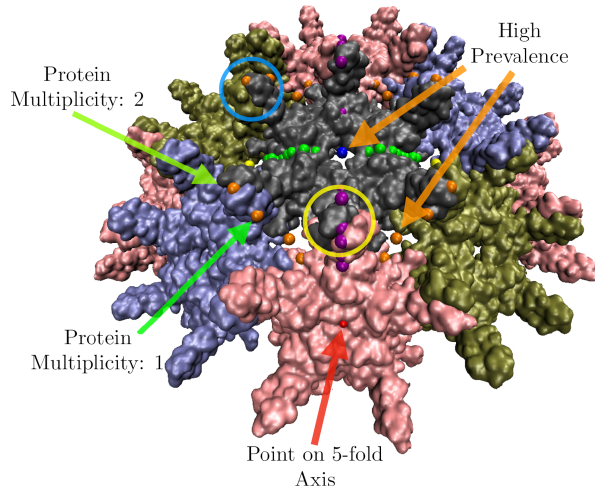
Figure 10. Features of the point array fitting algorithm. Here we have docked the gauge points on HBV, a T = 4 virus with dimeric protrusions. We only consider the point arrays with gauge points nearest the most radially distal protruding features, e.g., the nearest gauge points to the protruding dimers are GP: 17, 18 and 19 (yellow circles) and 4 and 5 (blue circles), see Table 2. In this example, there are 3 gauge points that would have fallen through the capsid surface when docked, which were instead stopped at their minimum distance to the surface. We see that most points sit on the surface of the proteins, and some on the symmetry axes in between proteins. Points which are near more than one protein are weighted more in the RMSD, through protein multiplicity p i , see Equation (2). High multiplicity always occurs on symmetry axes e.g., Gauge Point 1 (red) on the 5-fold axis would count 5 times. There are several points which would lead to a high prevalence, i.e., they do not intersect proteins over a large range of radial scaling, including Gauge Point 15 (blue) which is on a 2-fold axis and Gauge Point 3 (orange). In this example, these points would lead to a poor RMSD fit, as they are each several angstroms away from the surface.